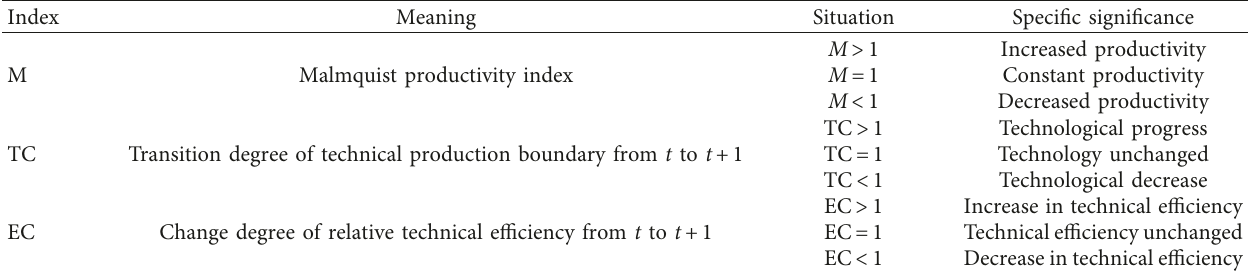
Table 1: Specific significance of each index in the Malmquist index.